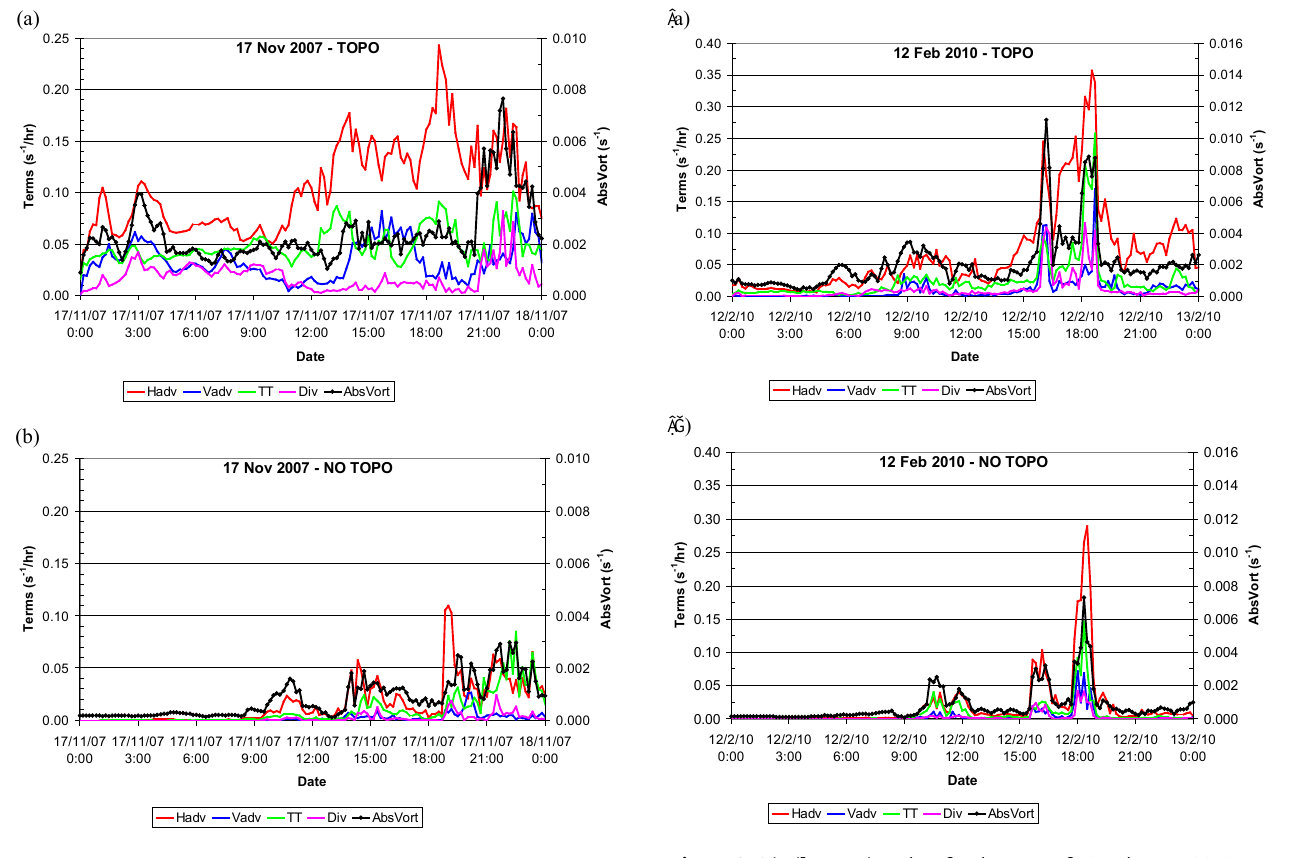
Figure 5. Time series of WRF maximum simulated values of Ab- solute Vorticity (s − 1 ) and of the vorticity equation terms (s − 1 h − 1 ) of horizontal (Hadv) and vertical advection (Vadv), tilting/twisting (TT), and divergence (DIV), at 1kma . s . l . in a box of 0 . 2 ◦ × 0 . 2 ◦ latitude–longitude centered at the actual location of the tornado of 17 November 2007, (a) with topography and (b) without topogra- phy. Time is inUTC.